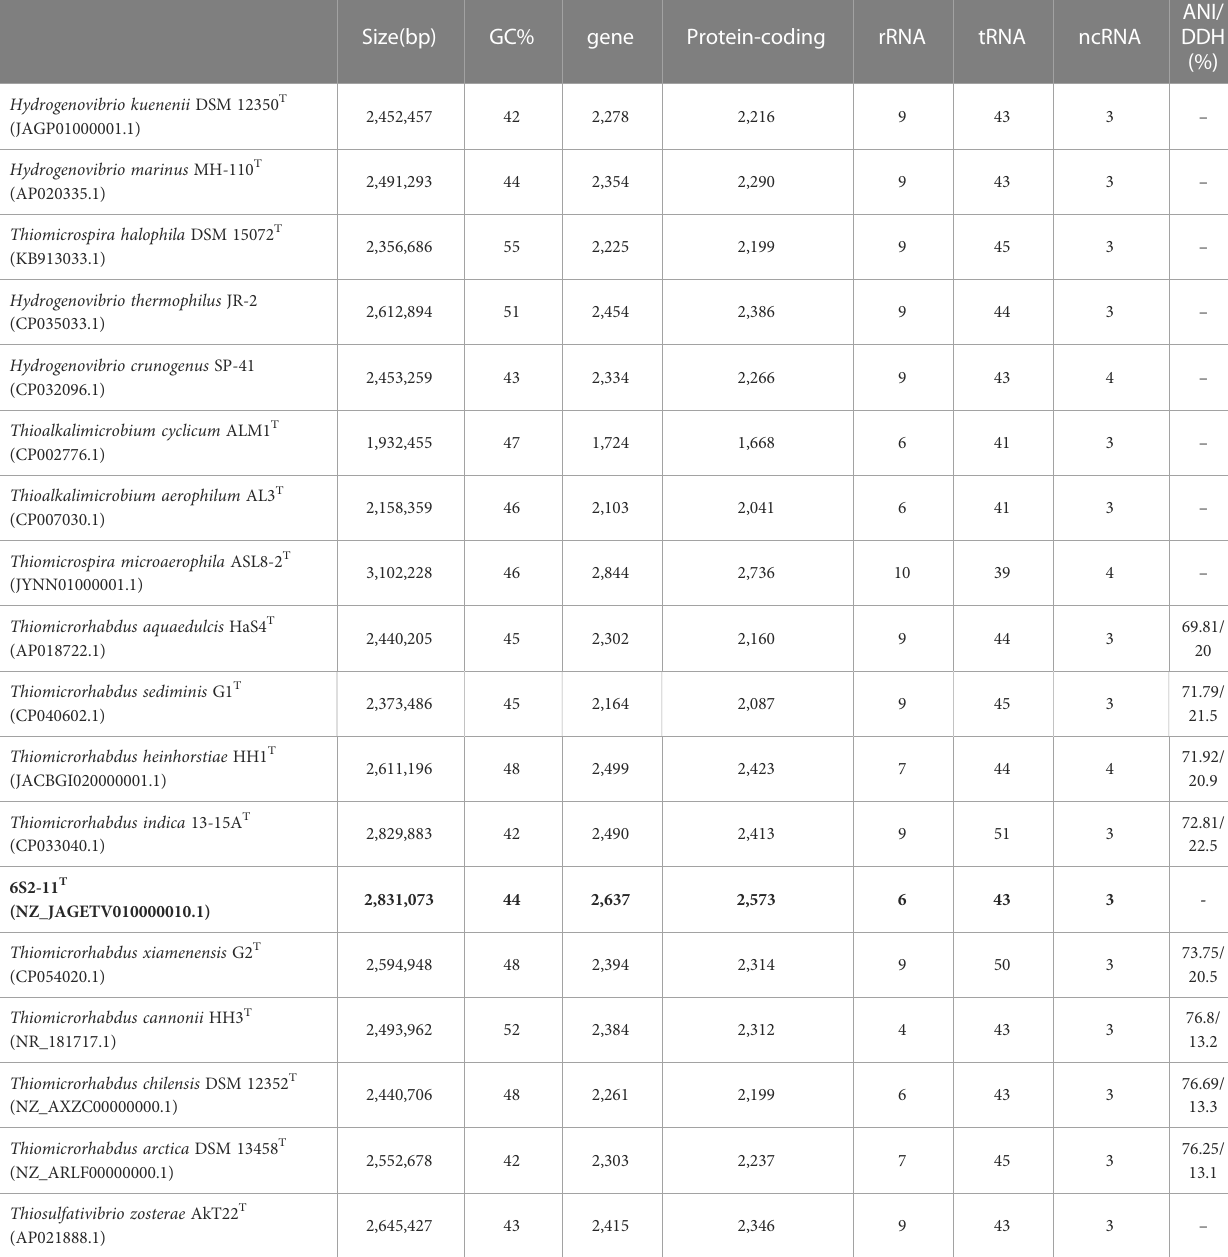
TABLE 1 Genomic characteristics of all strains and ANI/DDH values between strains of genus Thiomicrorhabdus and strain 6S2-11 T